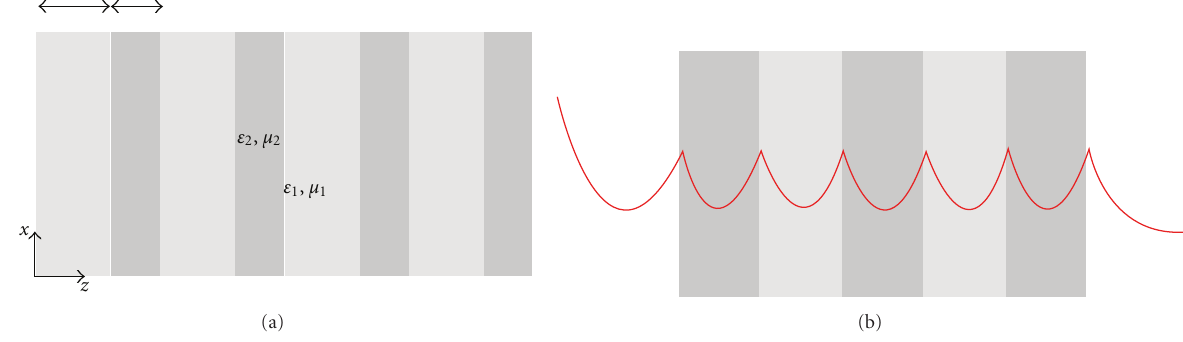
Figure 11: Multilayered, periodic metal-insulator stacks (a) and the schematic E -field profile (b) inside